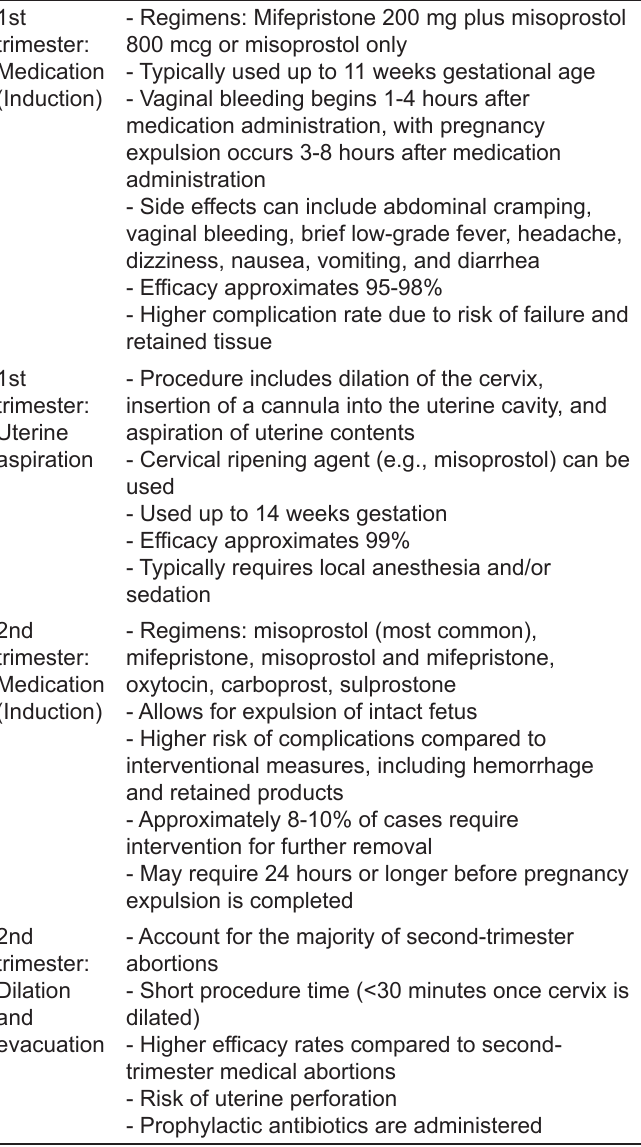
Table 1. Safe abortion types. Table 2. Unsafe abortion types and